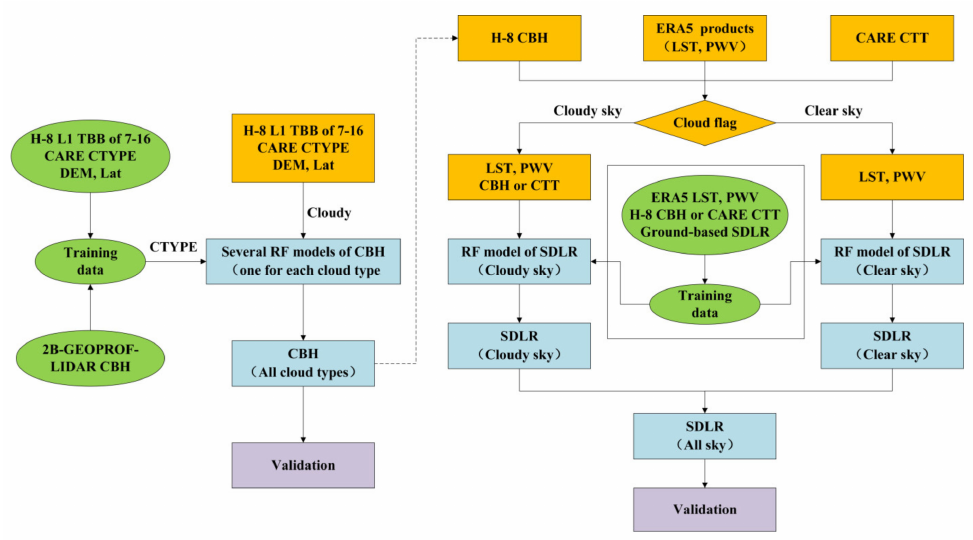
Figure 1. Flowchart for the estimation of CBH and the all-sky SDLR based on